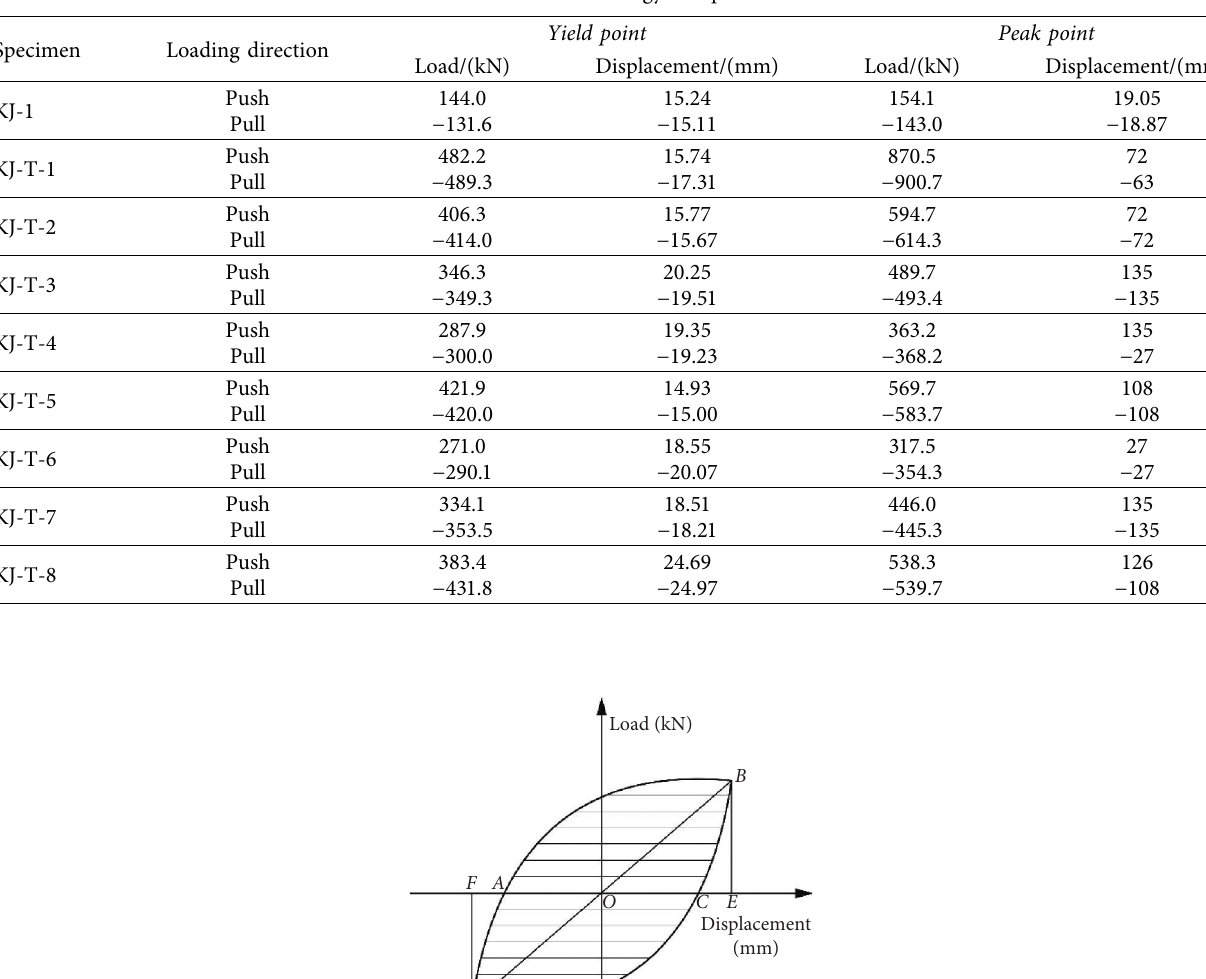
Table 4: /e results of the energy dissipation coefficient.